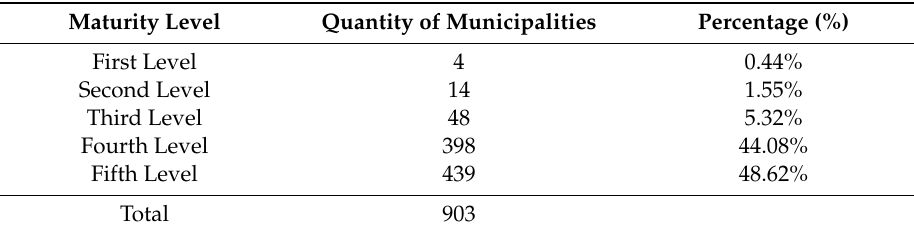
Table 10. Number of municipalities by level of